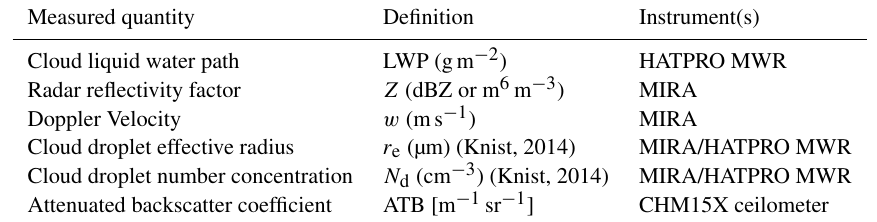
Table 1. Cloud and aerosol properties measured or derived from the observations at the CESAR Observatory in the Netherlands.